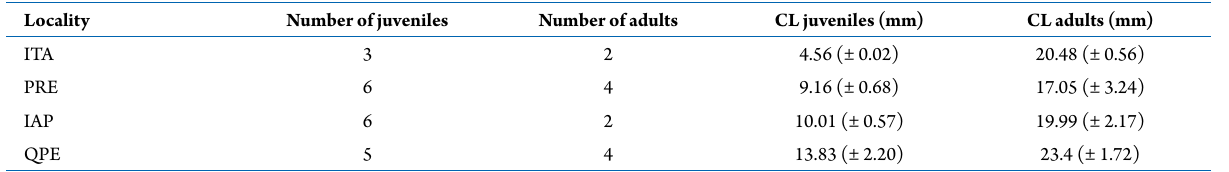
Table 1. Aegla castro. Number of individuals (juveniles and adults) and means (± standard deviation) of carapace length (CL mm) (juvenile and adults), for aeglids at Itatinga from São Paulo State (ITA: Itaúna stream, Paranapanema sub-basin) and Mauá da Serra (PRE: Preto stream, Tibagi sub-basin), Castro (IAP: Iapó stream, Tibagi sub-basin) and Ponta Grossa (QPE: Quebra Perna stream, Tibagi sub-basin) in Paraná